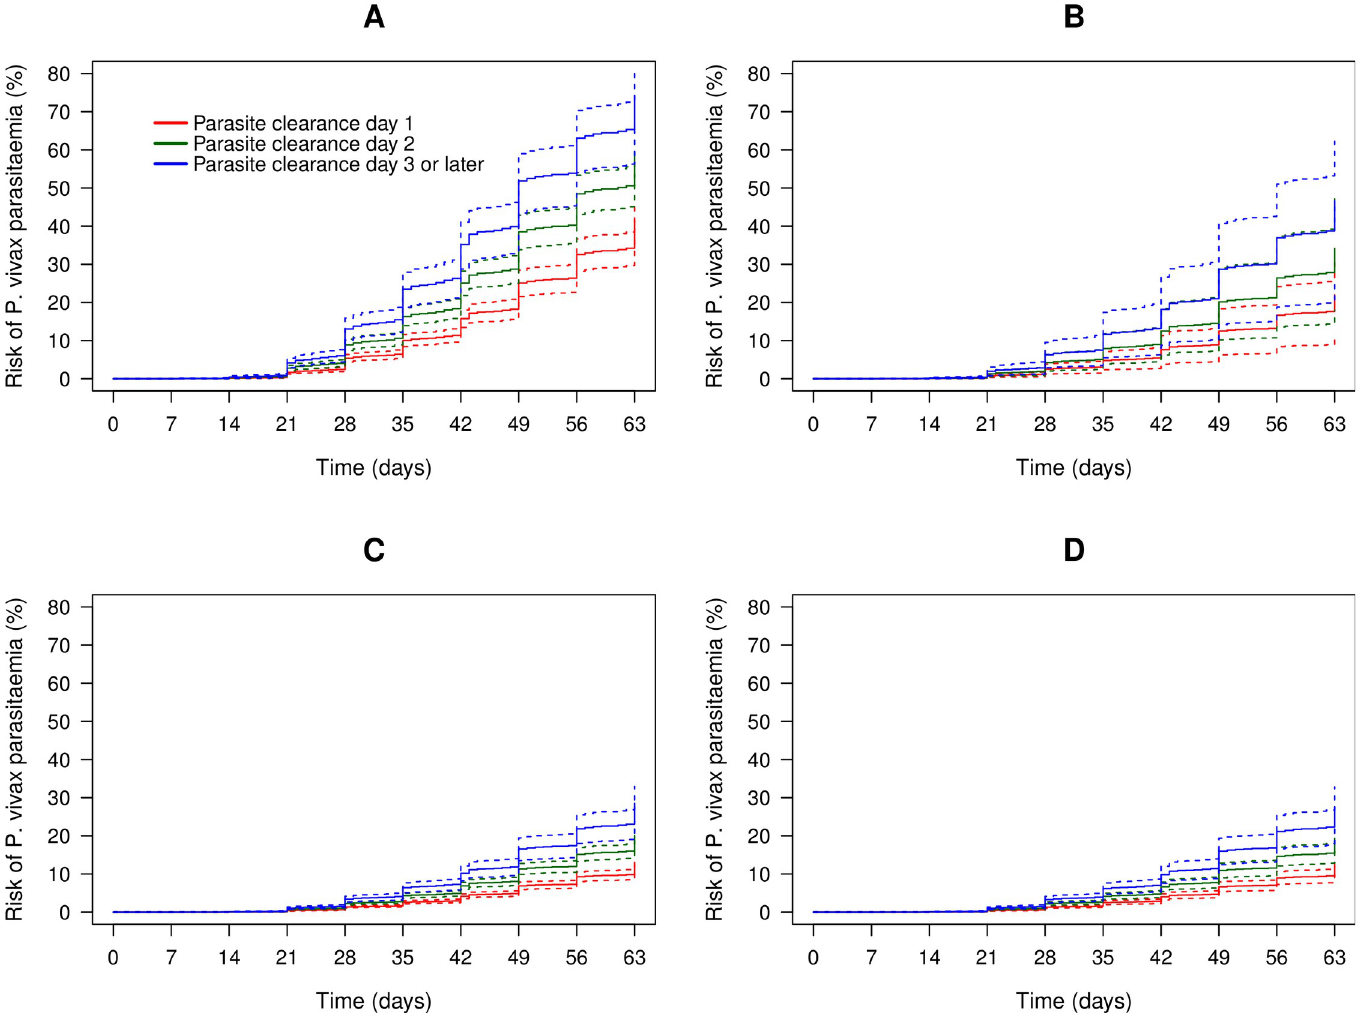
Fig 8. Risk of P . vivax parasitaemia following falciparum infection between days 7 and 63 according to treatment and day of parasite clearance: (A) AL, (B) AA, (C) AM, and (D) DP. Figure adjusted for age, sex, baseline parasitaemia, regional relapse periodicity, P . falciparum gametocytes, mixed infection at baseline, and Hb at baseline, assuming no study-site effect. AA, artesunate-amodiaquine; AL, artemether-lumefantrine; AM, artesunate-mefloquine; DP, dihydroartemisinin-piperaquine; Hb, haemoglobin.